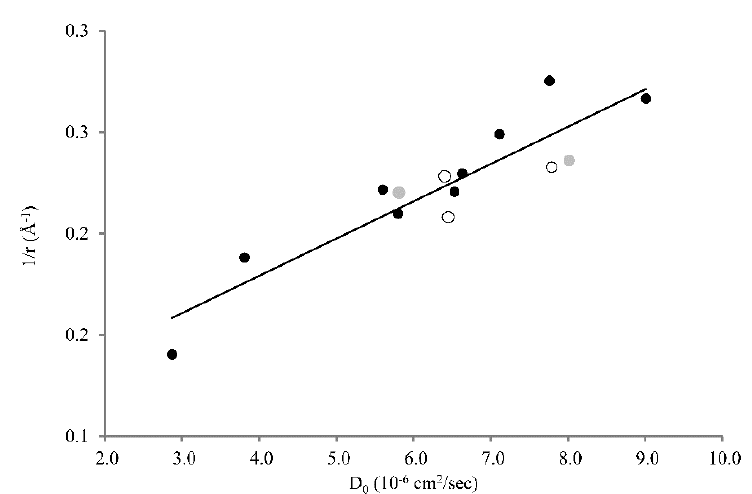
Figure 2. Correlation between D 0 of 14 compounds and their estimated molecular radii (r) (D 0 vs. 1/r). Empty dots represent the compounds measured in this work whereas grey and the black dots correspond to data taken from the literature [12,13]. Table 2. Analytical parameters obtained from Equation (1). C n expresses the nominal initial concentration in the donor, D 0 the diffusion coefficient in plain water, A 0 the initial amount injected and σ the width of the initial distribution of the tested drug (ATN, CAF, HYD , and NPR). Data reported are the average of two parallel experiments (variation below 5% and fitting error below 1%).